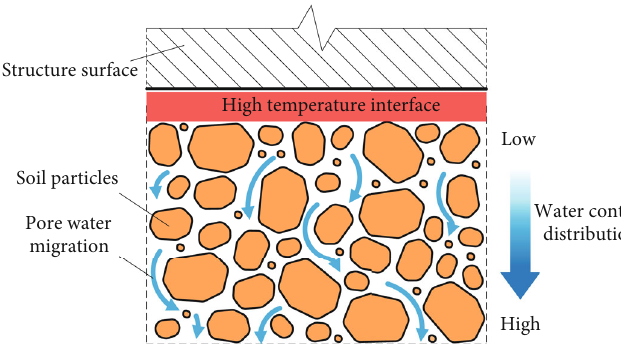
Figure 8: Migration of pore water.